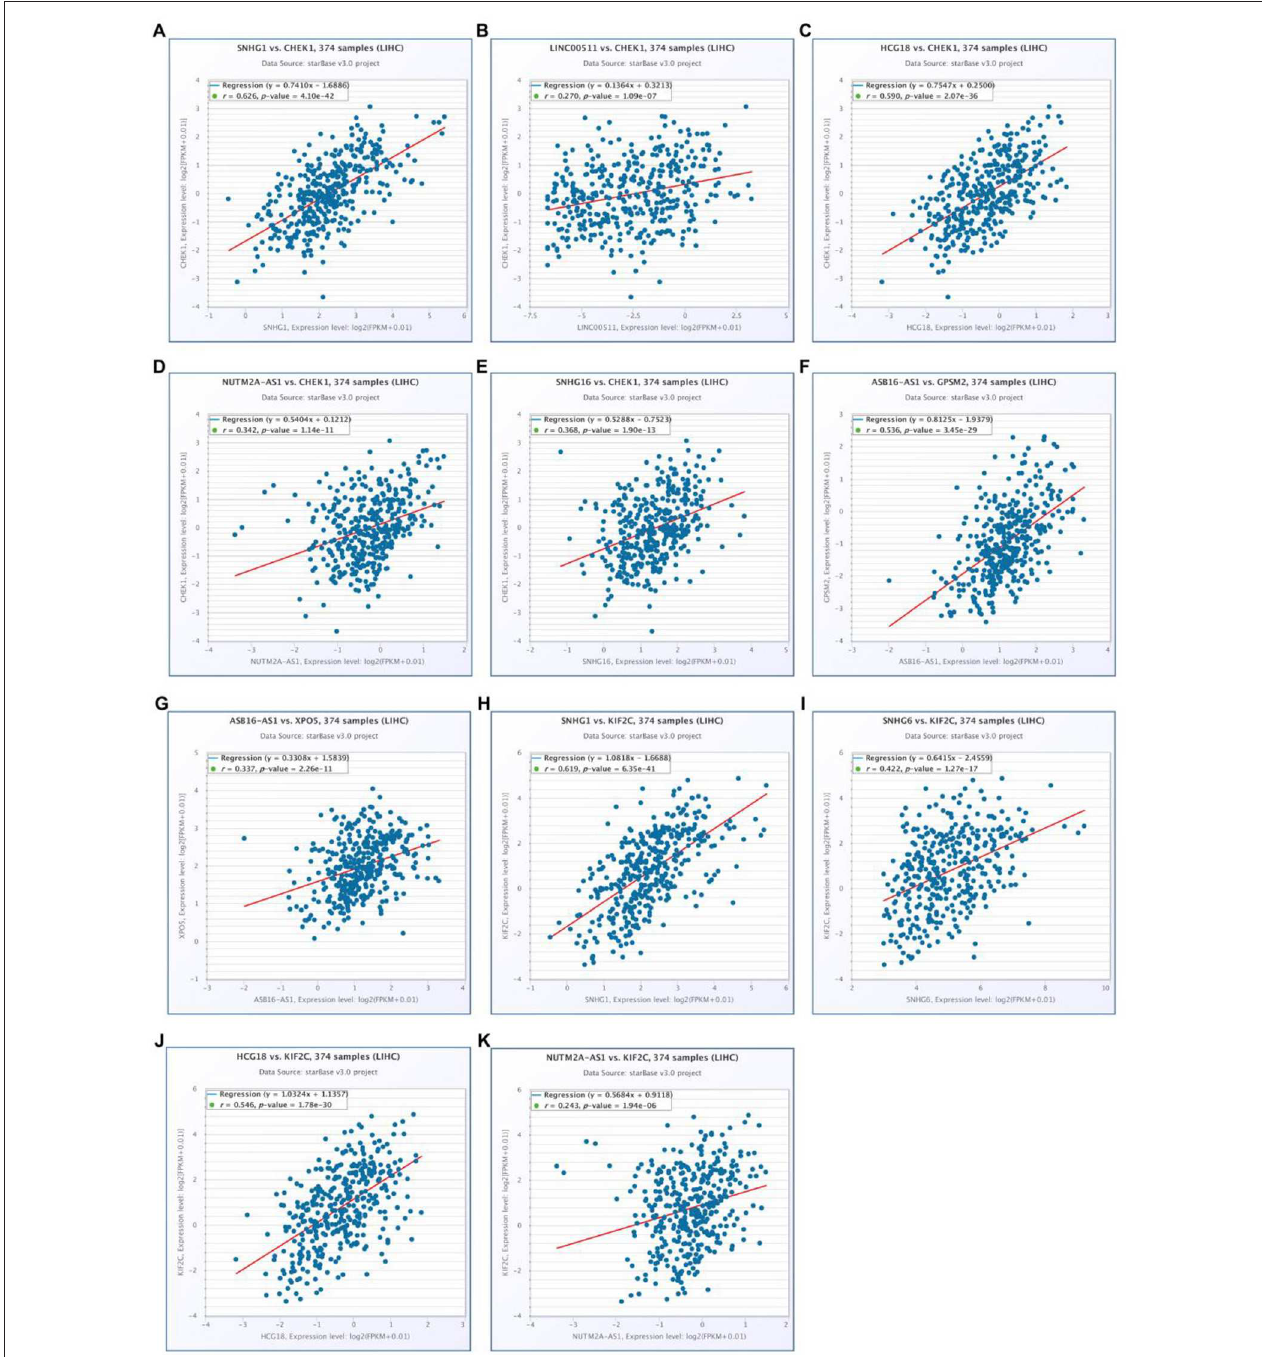
FIGURE 9 | Correlation analysis of potential mRNA-lncRNA pairs in hepatocellular carcinoma determined by starBase. (A) SNHG1 expression was significantly positively correlated with CHEK1 expression in hepatocellular carcinoma; (B) LINC00511 expression was significantly positively correlated with CHEK1 expression in hepatocellular carcinoma; (C) HCG18 expression was significantly positively correlated with CHEK1 expression in hepatocellular carcinoma; (D) NUTM2A-AS1 expression was significantly positively correlated with CHEK1 expression in hepatocellular carcinoma; (E) SNHG16 expression was significantly positively correlated with CHEK1 expression in hepatocellular carcinoma; (F) ASB16-AS1 expression was significantly positively correlated with GPSM2 expression in hepatocellular carcinoma; (G) ASB16-AS1 expression was significantly positively correlated with XPO5 expression in hepatocellular carcinoma; (H) SNHG1 expression was significantly positively correlated with KIF2C expression in hepatocellular carcinoma; (I) SNHG6 expression was significantly positively correlated with KIF2C expression in hepatocellular carcinoma; (J) HCG18 expression was significantly positively correlated with KIF2C expression in hepatocellular carcinoma; (K) NUTM2A-AS1 expression was significantly positively correlated with KIF2C expression in hepatocellular carcinoma.